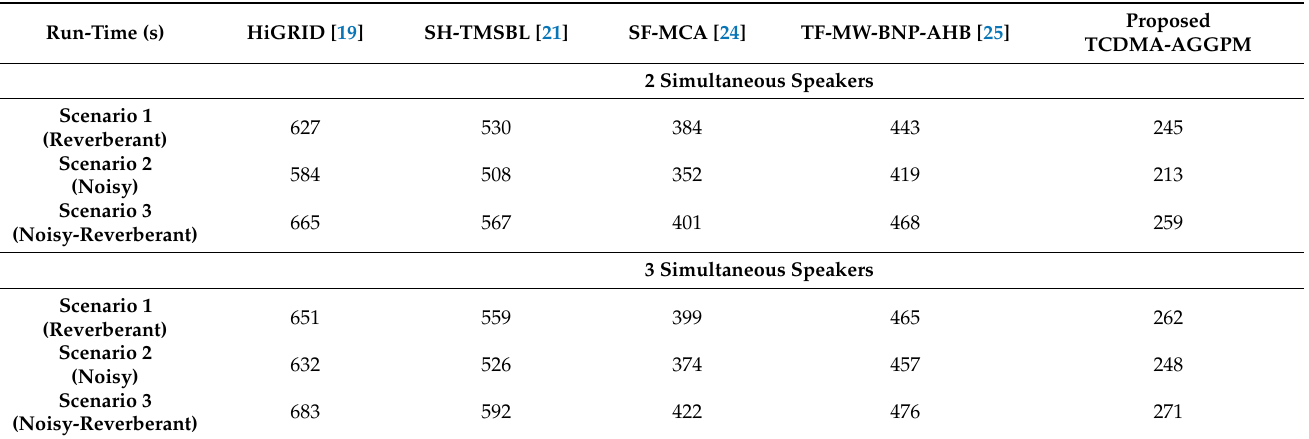
Table 4. The run-time (in seconds) comparison between the proposed TCDMA-AGGPM, HiGRID, SH-TMSBL, SF-MCA, and TF-MW-BNP-AHB methods for 2 and 3 simultaneous speakers on real data in noisy-reverberant